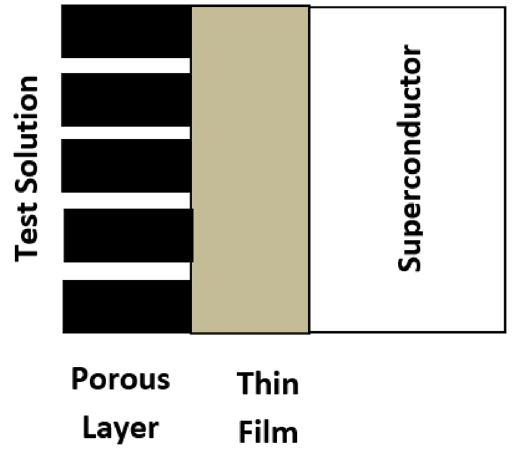
Figure 7. Schematic for physical interpretation.